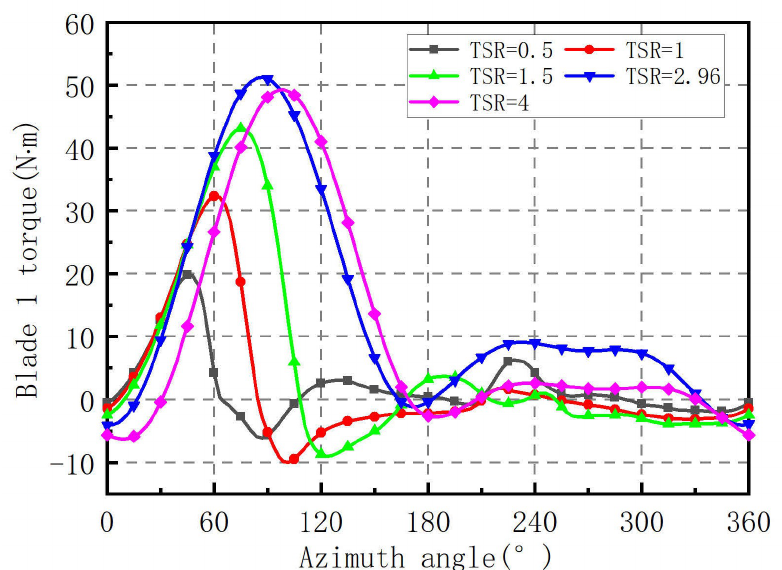
Figure 19. Curve of torque changing with azimuth.